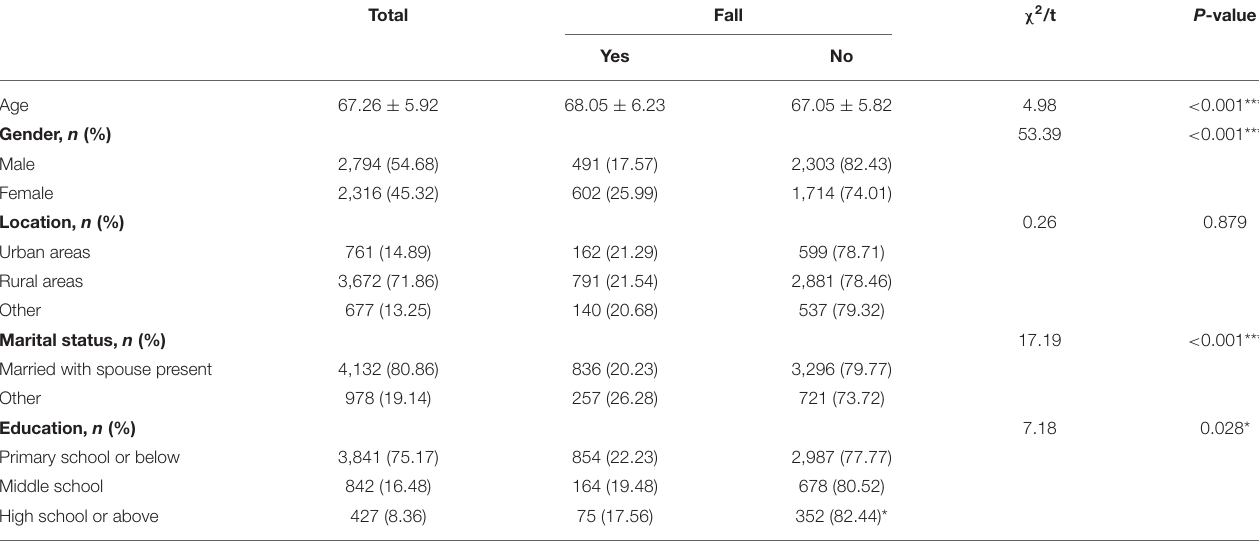
TABLE 1 | Comparison of demographic characteristics between the non-fallers group and the fallers group ( n = 5,110). Total